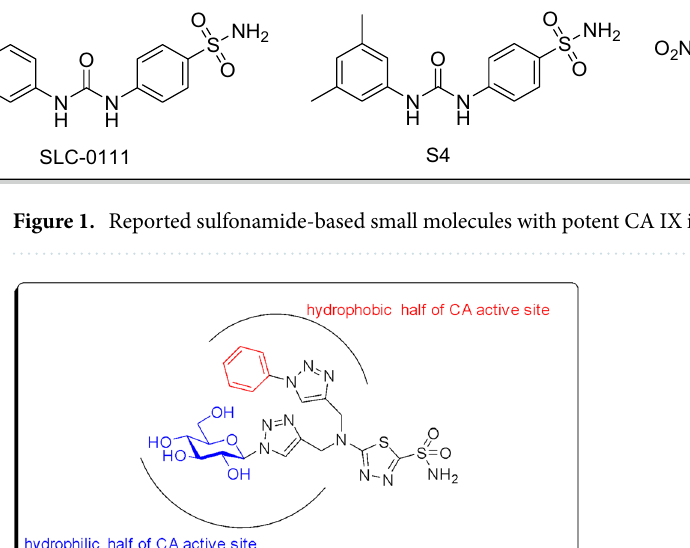
Figure 2. Dual tail concept in designing novel CA inhibitors 35